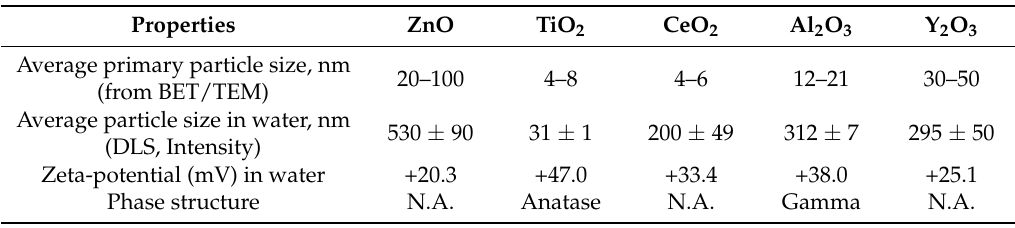
Table 2. Summary of metal oxide NPs